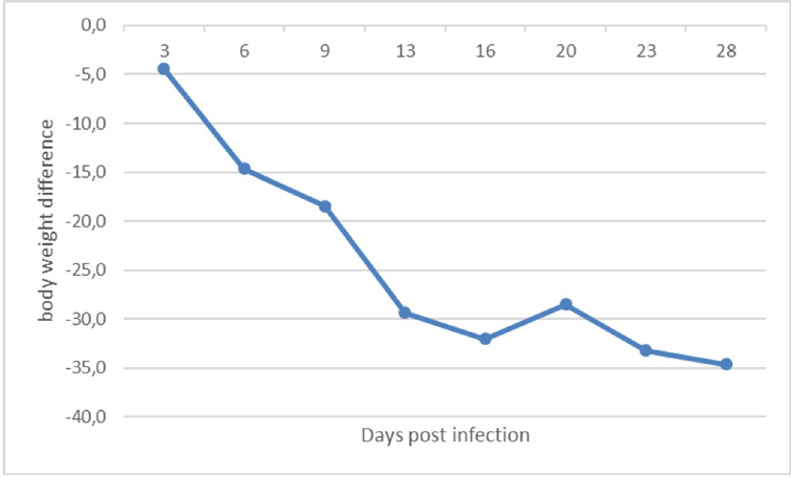
Fig 1. Mean body weights differences from infected SPF chickens to negative controls at 3, 6, 9, 13, 16, 20, 23 and 28 days post infection.